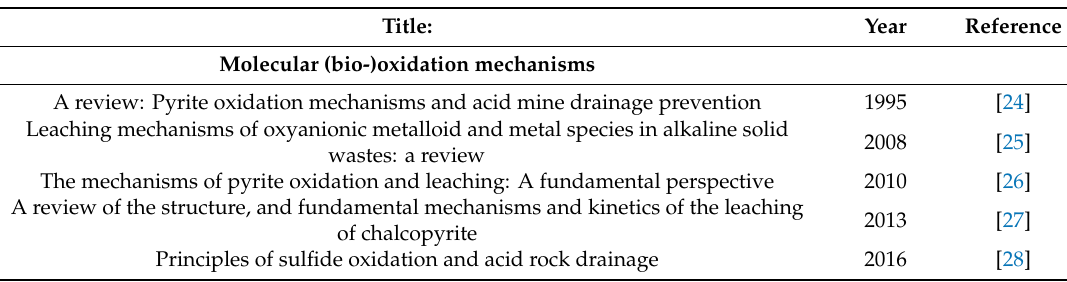
Table 1. Reviews on various aspects of mine waste rock: weathering mechanisms, microbial interactions, characterization of physicochemical (bulk) properties, management, and